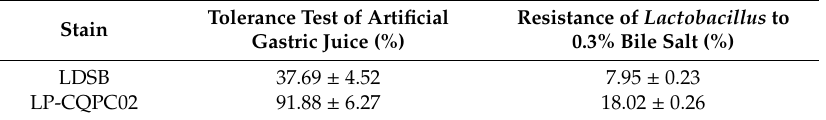
Table 3. Resistance of lactic acid bacteria to artificial gastric juice and bile salt.